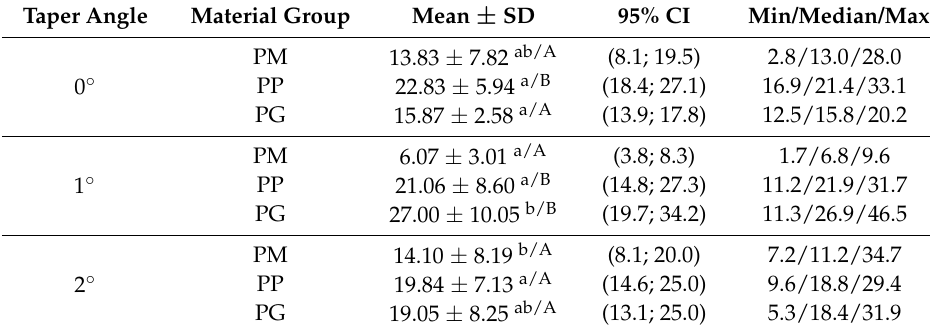
Table 1. Descriptive statistics such as mean with standard deviation (SD), 95% confidence intervals (95% CI), and the robust statistics (minimum/median/maximum). All values for retention load are presented in Newton